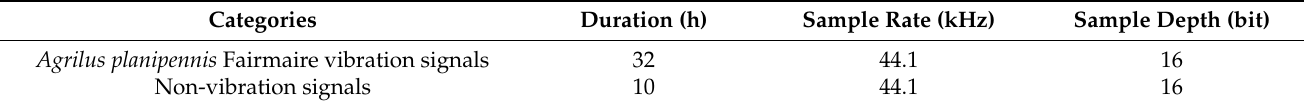
Figure 2. Schematic view of the sensor embedded in a wood segment.